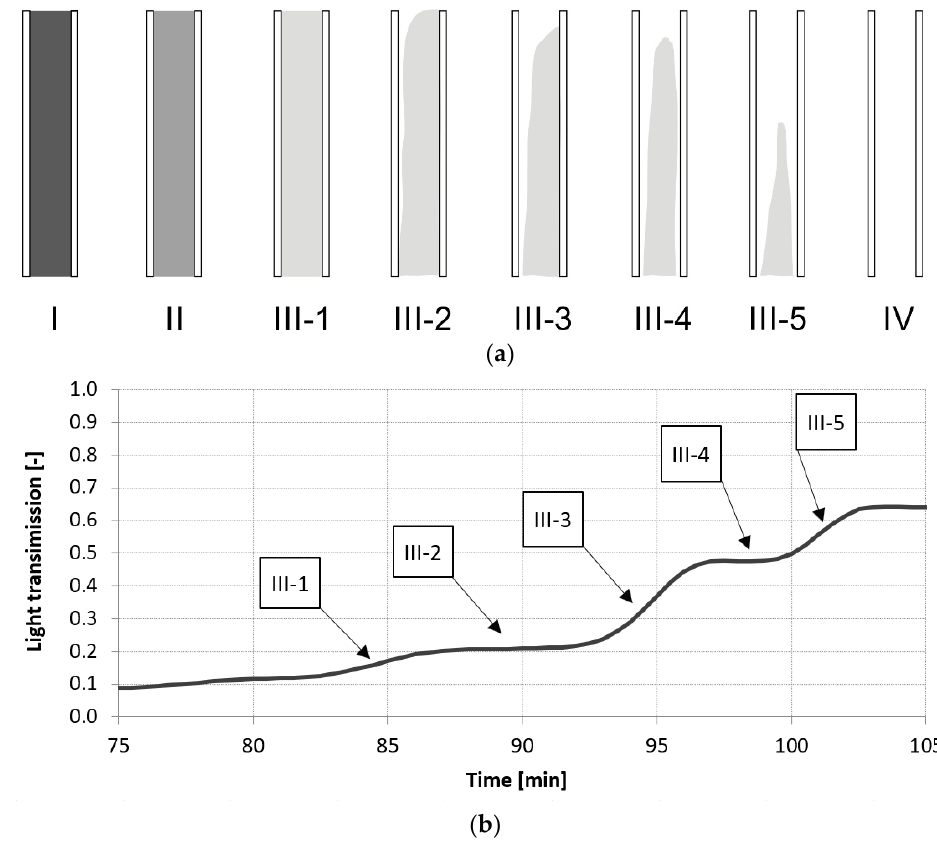
Figure 14. Analysis of melting process in PCM cavity from mushy to liquid, ( a ) graphical representations, ( b ) changes of transmission.